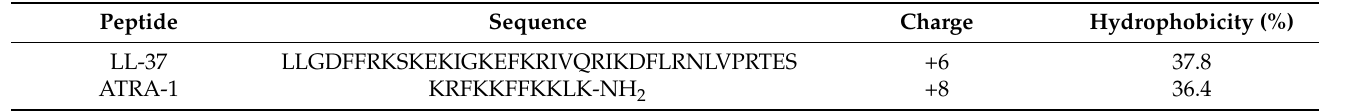
Table 1. Overview of the characteristics of the AMPs used in this study. Peptide Sequence Charge Hydrophobicity (%) LL-37 LLGDFFRKSKEKIGKEFKRIVQRIKDFLRNLVPRTES +6